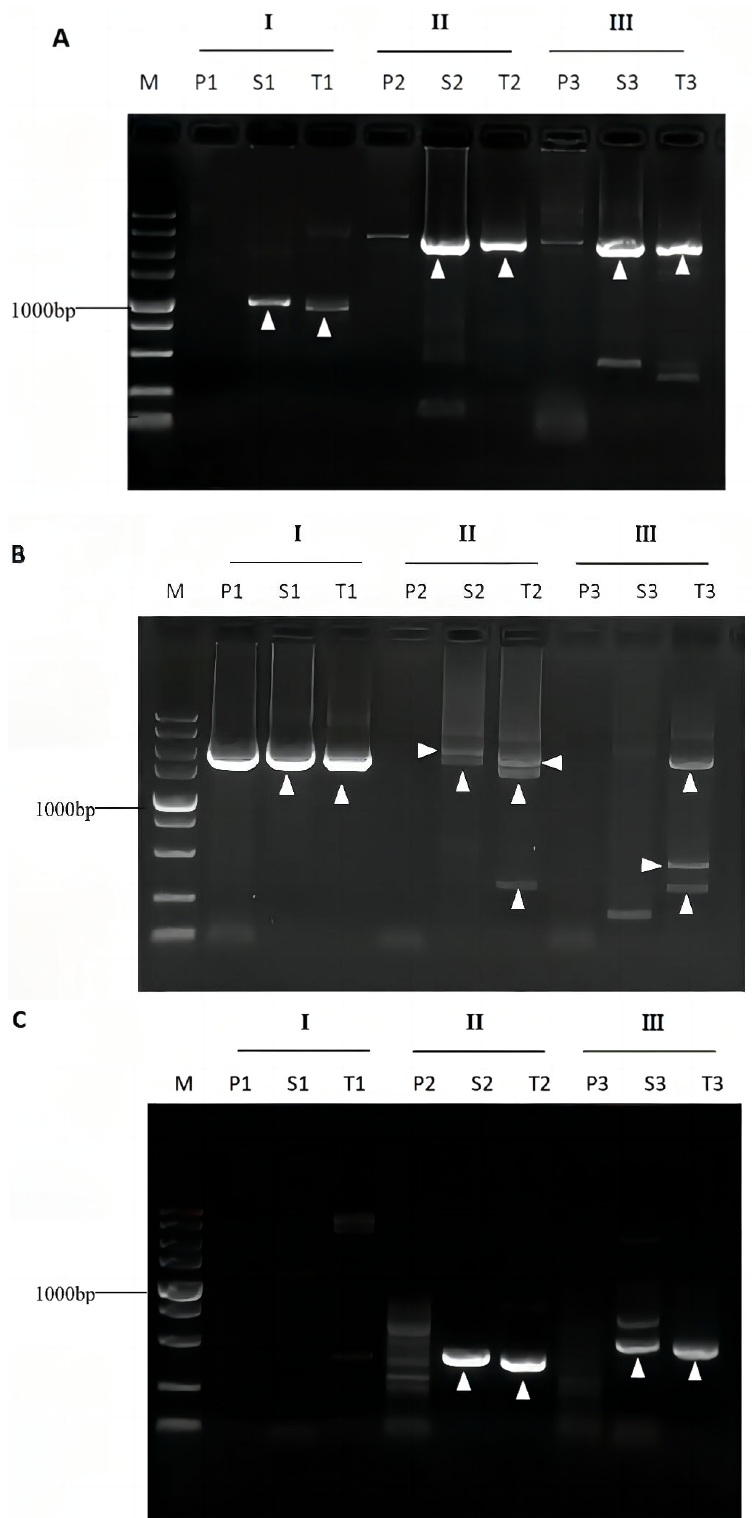
Figure 4. Genome-walking for gadA ( A ) and gadR ( B ) of L. brevis CD0817, and hyg ( C ) of rice. I, II, and III denote the three parallel sets of bridging PCRs in each walking experiment. Lanes P: primary PCR; S: secondary PCR; T: Tertiary PCR; and M: DNA5000 Marker (5000, 3000, 2000, 1500, 1000, 750, 500, 250, and 100 bp). The white arrowheads indicate the clear major bands.